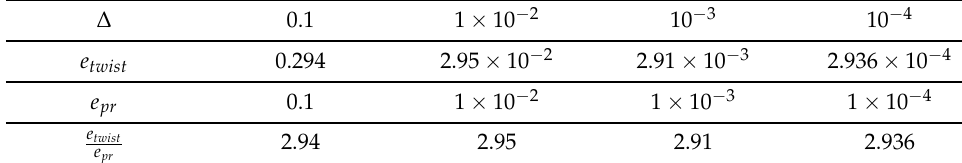
Figure 7. The simulation results of the closed-loop systems (59), (61) and (63). ( a ) Plots of ϕ ( t ) and ϕ z ; ( b ) Plot of ω ( t ) ; ( c ) Phase portrait of ω and τ ; ( d ) Plot of τ ( t ) . Table 2. The simulation results for non-ideal relay type with hysteresis.